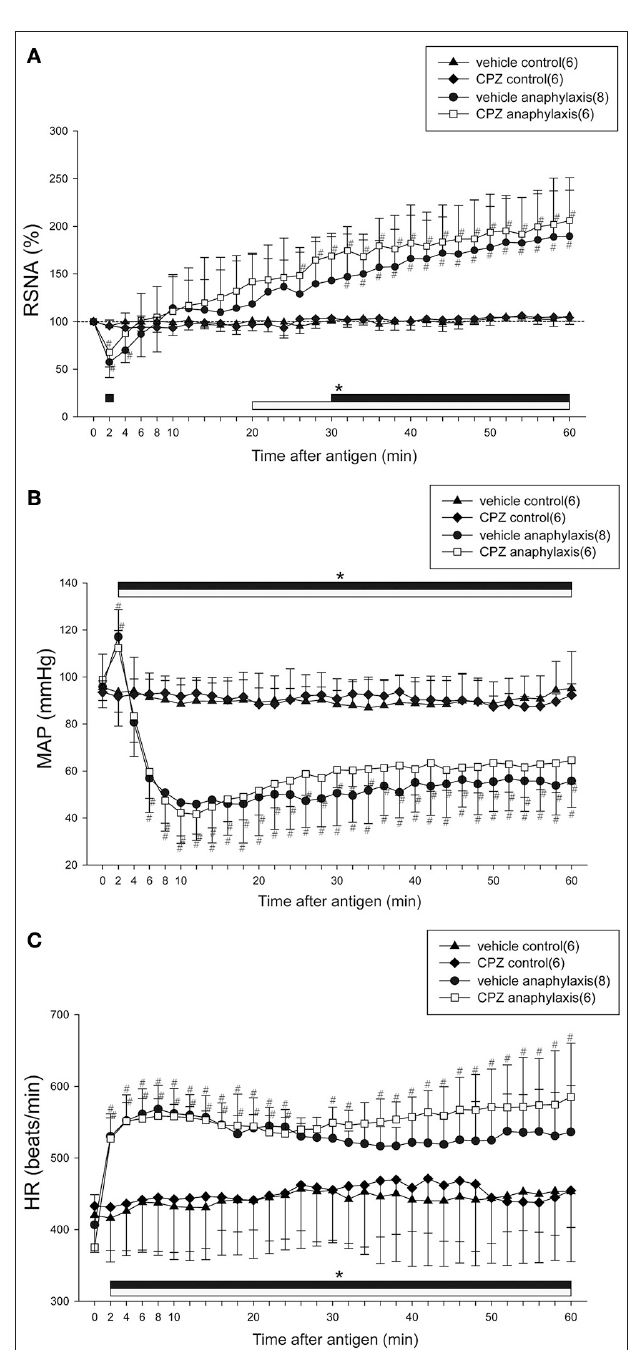
FIGURE 3 | Effects of a TRPV1 blocker on renal sympathetic and cardiovascular responses to anaphylactic hypotension. Time-course data of the changes in RSNA (A) , MAP (B) , and HR (C) after antigen injection in the sensitized and vehicle-pretreated mice ( • ; vehicle anaphylaxis), the sensitized and CPZ-pretreated mice ( (cid:3) ; CPZ anaphylaxis), the nonsensitized and vehicle-pretreated mice ( N ; vehicle control), and the nonsensitized and CPZ-pretreated mice ( (cid:7) ; CPZ control). The numbers of mice used are given in parentheses. Values are expressed as means ± SD. # P < 0.05 vs. the vehicle control group; * P < 0.05 vs. the baseline; the black bar and white bar show the significant changes in vehicle anaphylaxis group and CPZ anaphylaxis group,